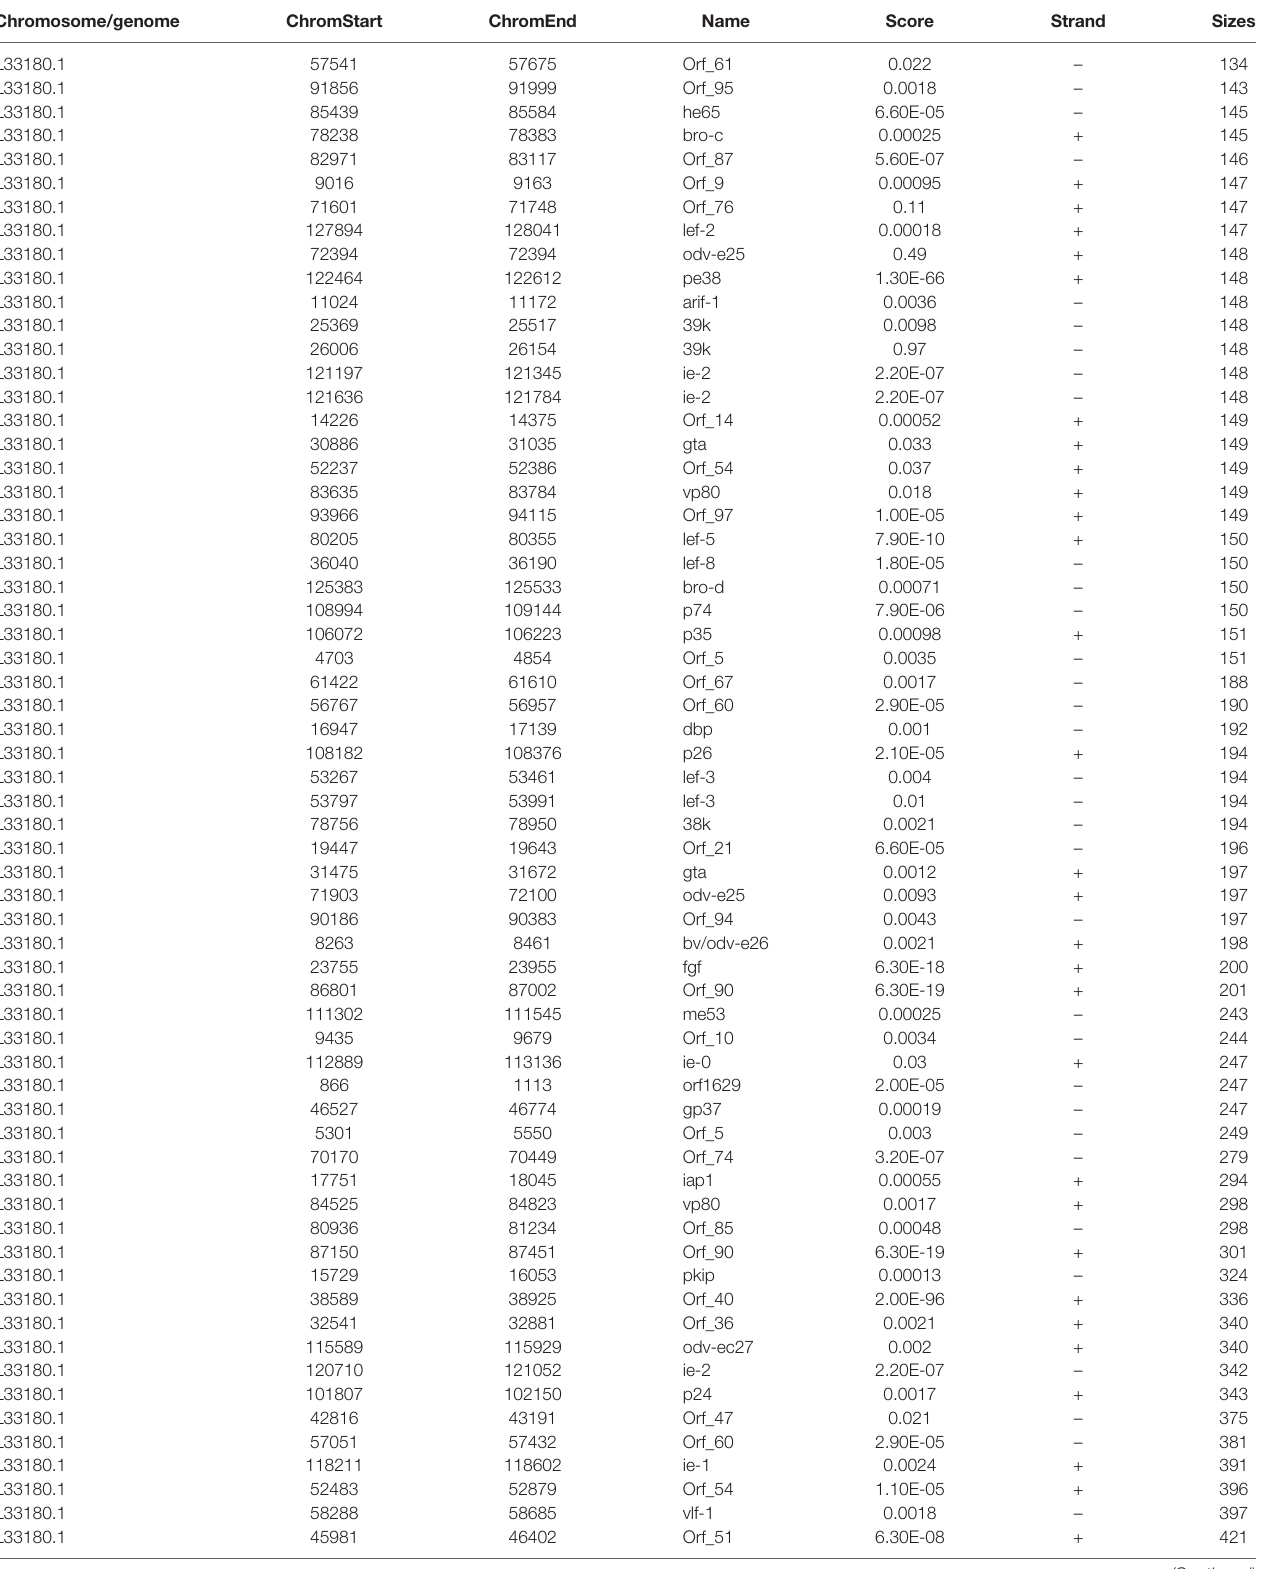
TABLE 1 | The information of m6A peaks on BmNPV transcripts from the MeRIP sequencing. Chromosome/genome ChromStart ChromEnd Name Score Strand Sizes